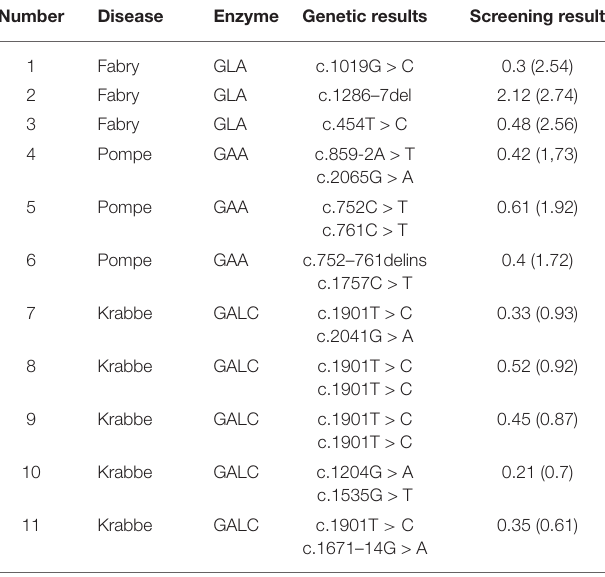
TABLE 2 | Genetic site information and enzyme activity in the screening experiment in confirmed